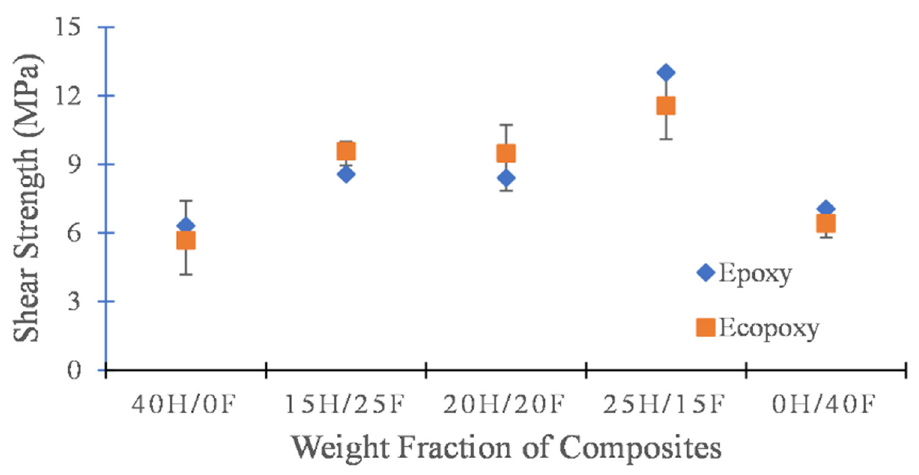
Figure 4. Interlaminar shear strength of epoxy and ecopoxy composites with various weight fractions.